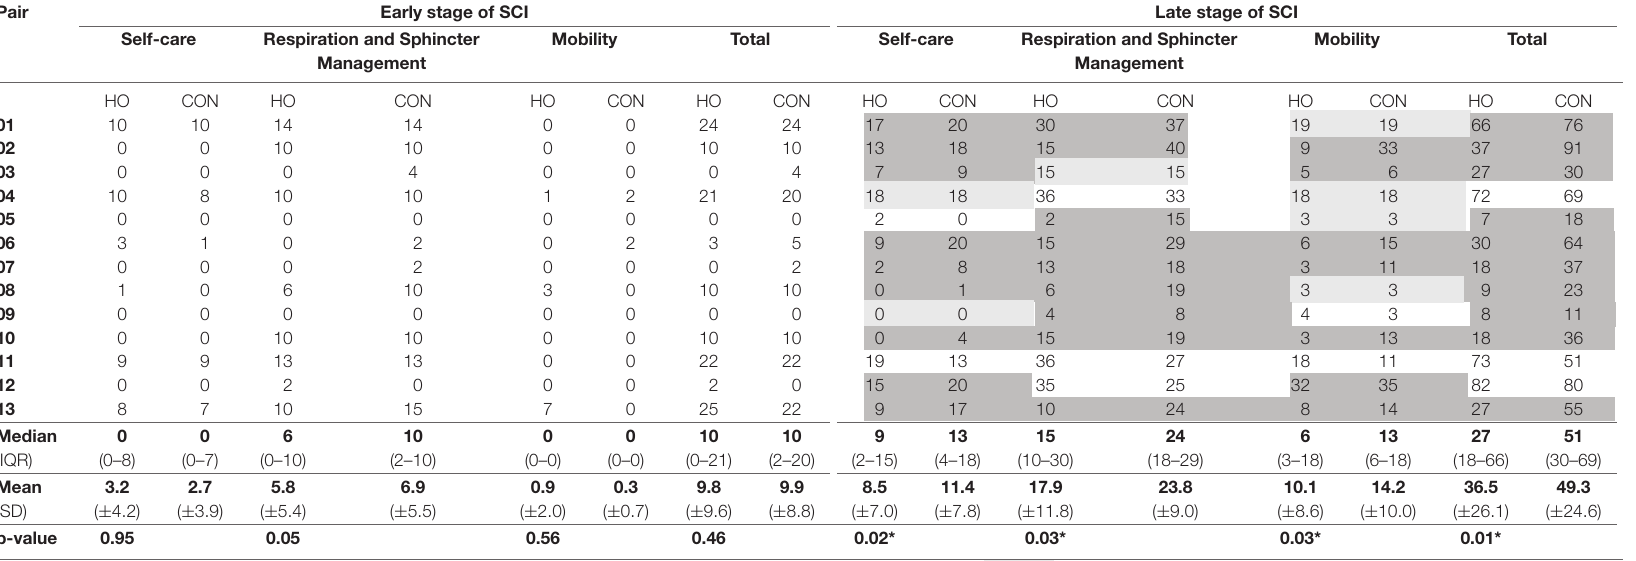
TABLE 3 | Detailed comparison of total SCIM and its subscales between individuals with heterotopic ossification and matched